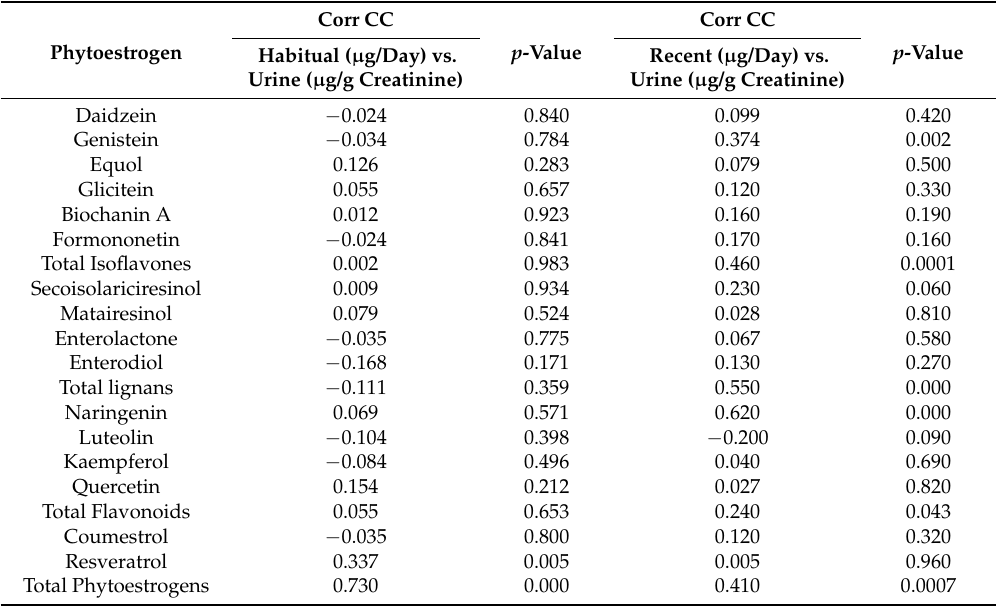
Table 6. Corrected correlation coefficients between urinary metabolites and dietary estimates of phytoestrogen intake (Habitual-FFQ and Recent-24 h recall). Corr CC Corr CC p -Value p -ValueHabitual ( µ g/Day) vs. Phytoestrogen Recent ( µ g/Day) vs. Urine ( µ g/g Creatinine) Urine ( µ g/g